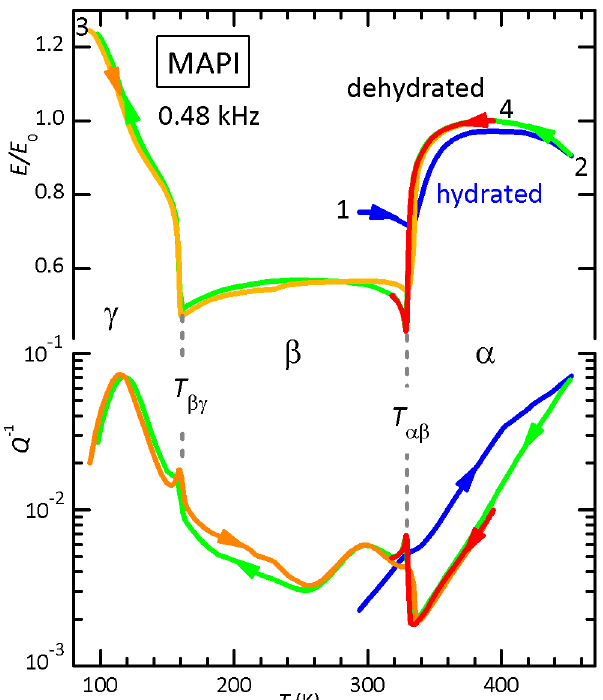
Figure 5. Relative change of the Young’s modulus and elastic energy loss of MAPI during temperature cycles in high vacuum. Curves 2–4 correspond to those in Figure 1 of [40]. Adapted with permission from ref. [40]. Copyright (2018) American Chemical Society.